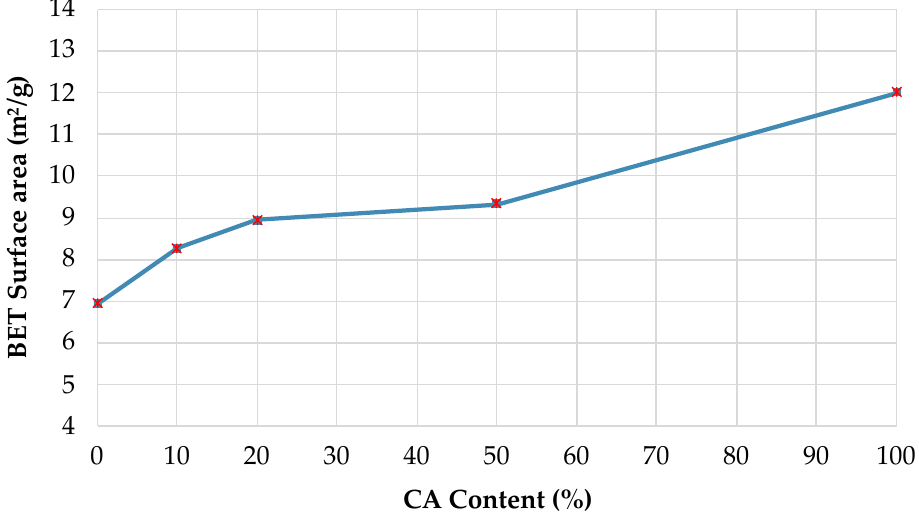
Figure 6. BET surface area according to the Recycled Ceramic Aggregate (CA) content in the Recycled Ceramic Mortars (RCM).